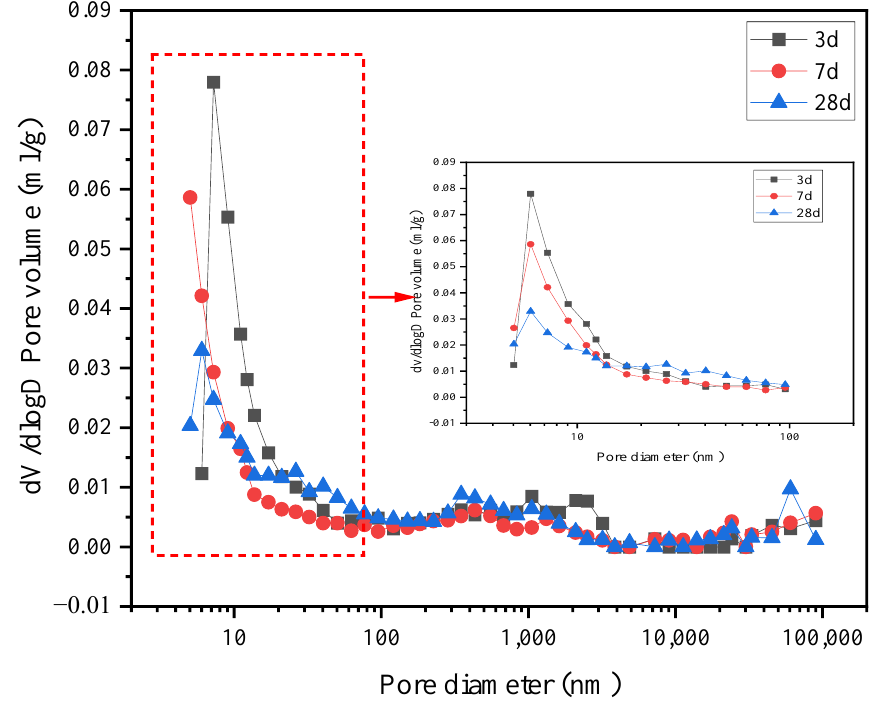
Figure 10. Differential curve of the pore size distribution of the G0 paste.